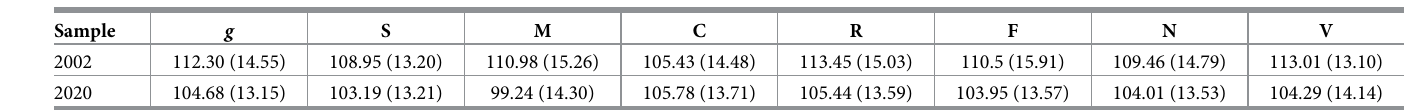
Table 3. Means (and SD ) of the different ability scores in Analysis 1a.